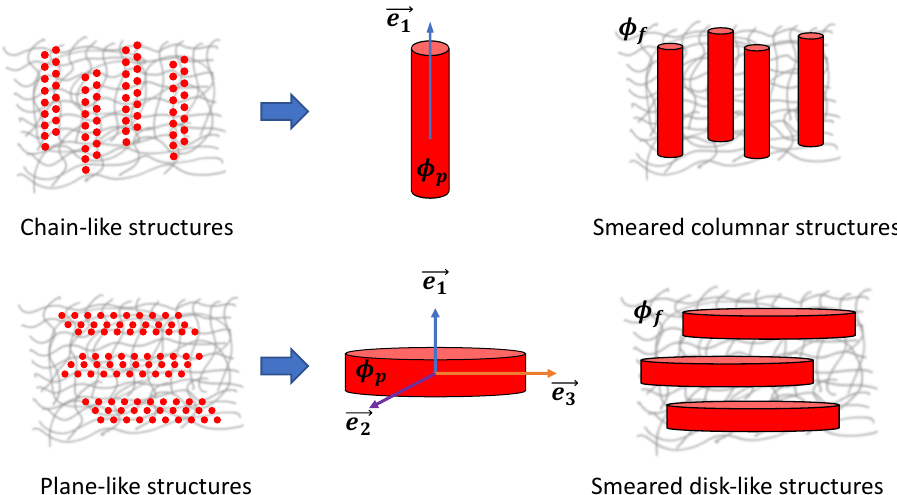
Figure 1. Smearing of magnetic particles (total volume fraction φ ) into columnar and disk-like structures. φ p is the volume fraction of magnetizable particles inside a smeared structure, and φ f = φ represents the volume fraction of smeared structures inside an elastomer matrix. MAEs, in both cases, exhibit transverse isotropy along a unit vector (cid:126) e 1